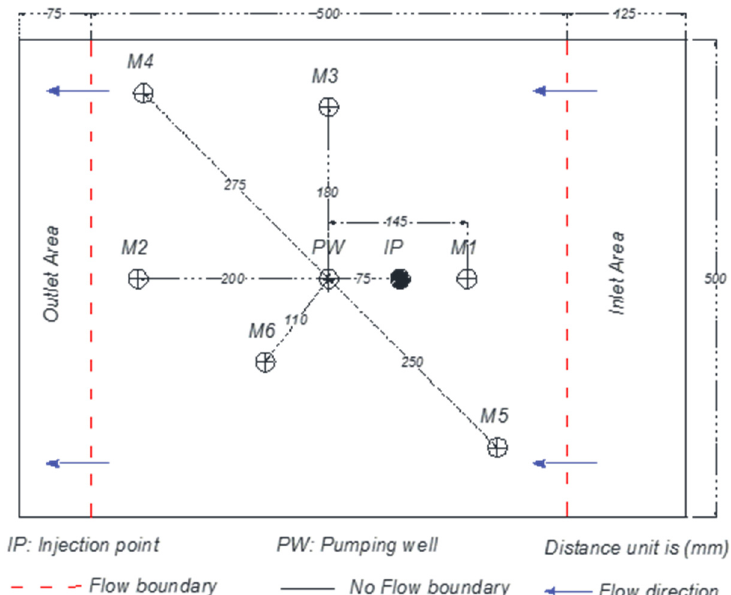
Figure 1. Top view of wells and inlet and outlet chambers of the tank. Distances of the monitoring wells from the pumping well (PW) are given in millimeters (mm).